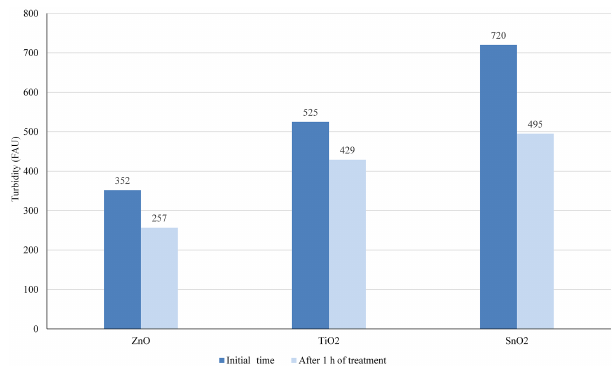
Figure 13. The change in turbidity of aqueous suspensions of ZnO, TiO 2 and SnO 2 in the beginning and after 1h of treatment using the advanced oxidation method with NaOCl. (The turbidity index is given in formazin attenuation units,